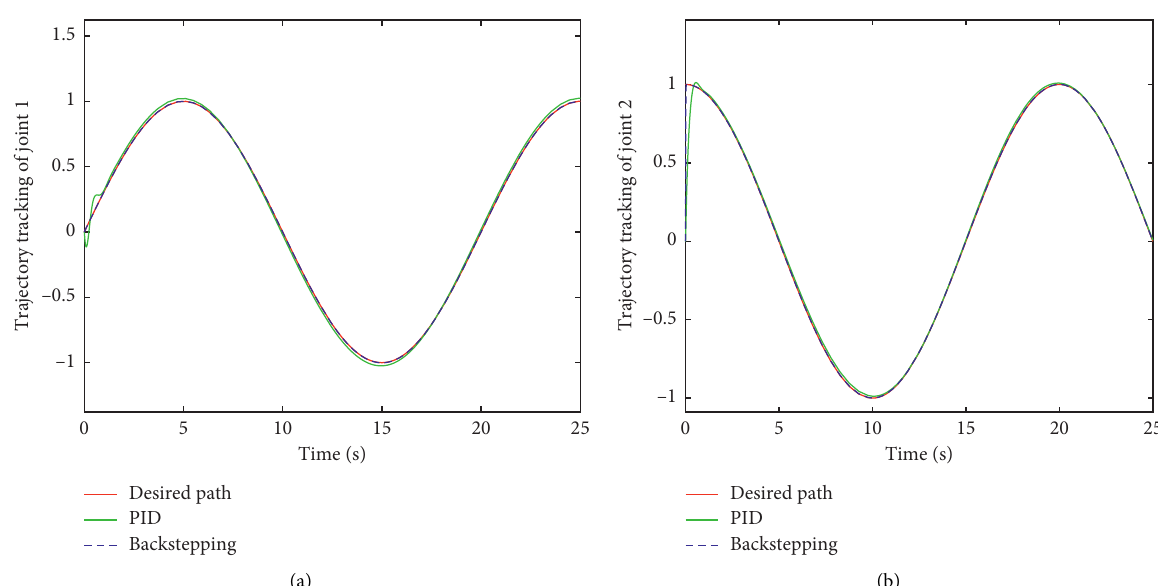
Figure 5: Trajectory tracking of two-link robotic manipulator. (a) 1# link with q